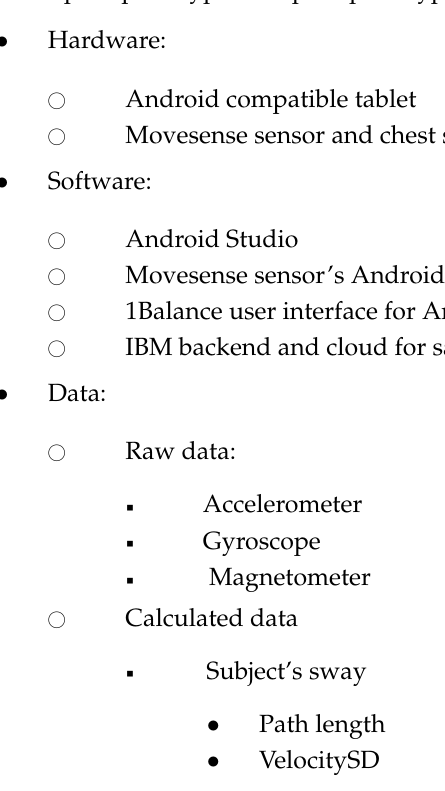
Figure 4. Screenshot of the software for the game prototype.